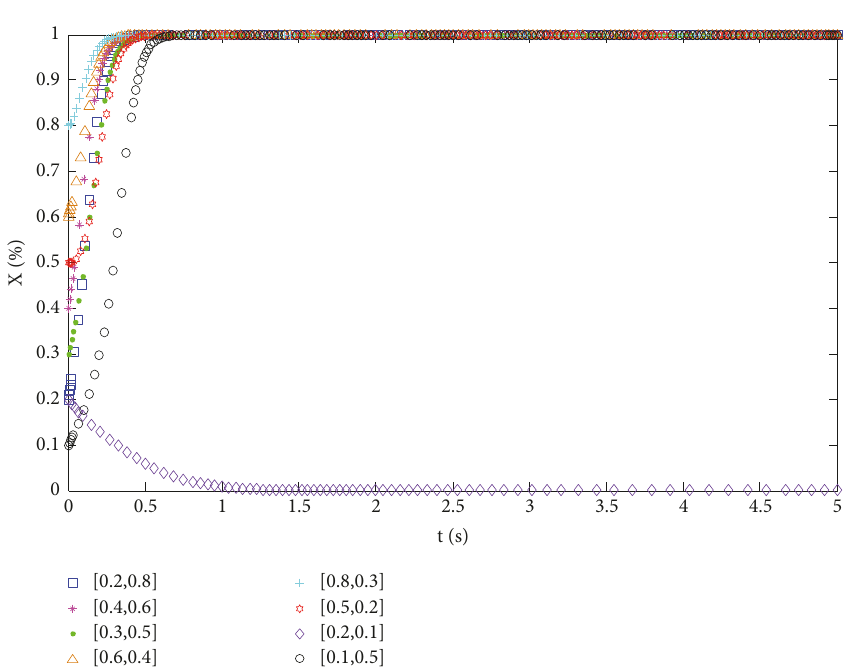
Figure 5: The X-t type of phase diagram (ESS: D(1,1) &